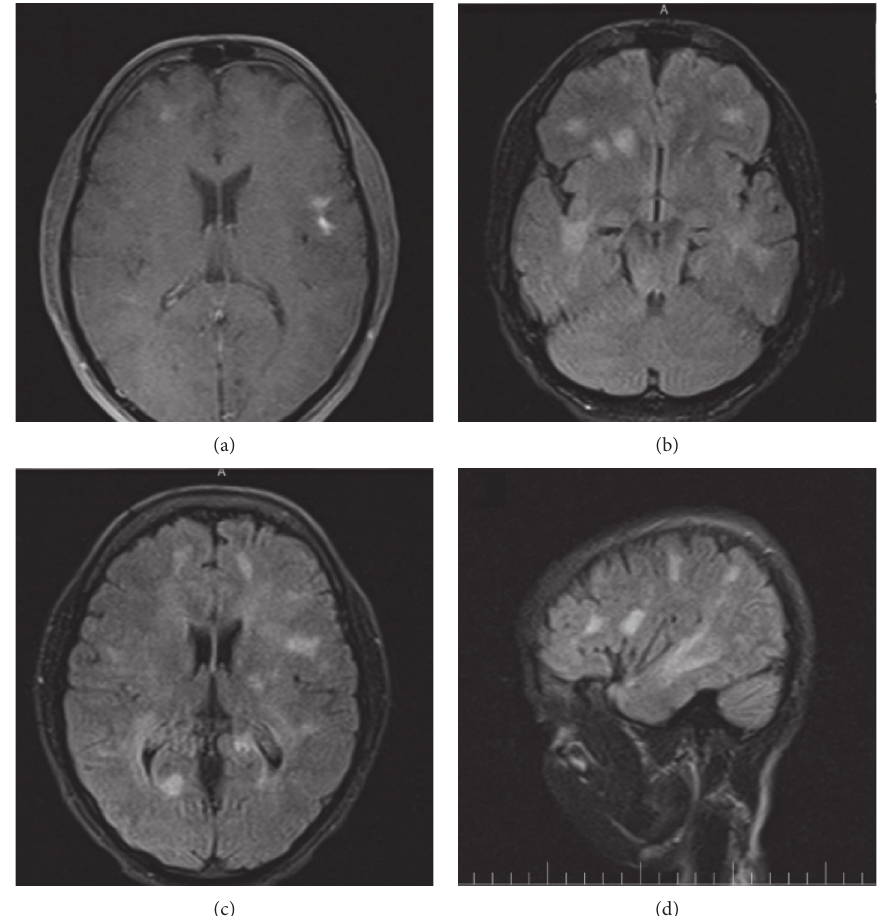
Figure 1: (a) Head-MRI T1 sequence with gadolinium demonstrates various hypersignal lesions in favor of active demyelinating plaques in left temporal and right frontal areas of the brain. (b, c) Axial and (d) sagittal FLAIR views show plaques with larger sizes in deeper areas of the